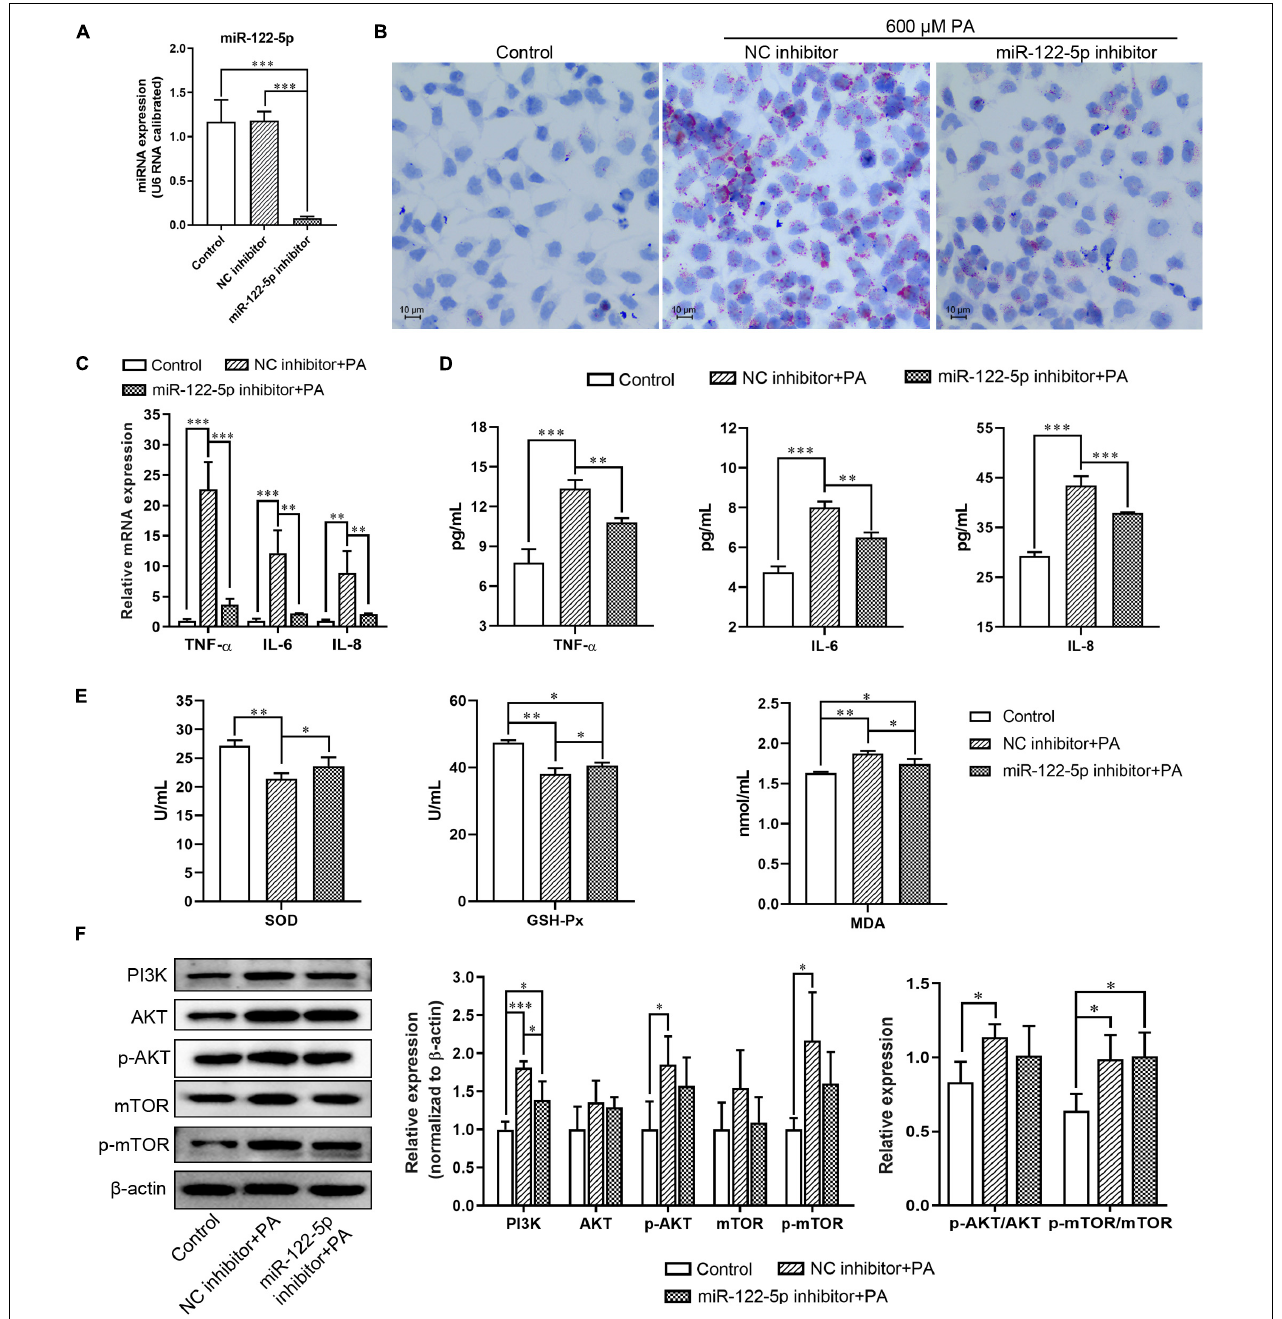
FIGURE 2 | MiR-122-5p inhibition attenuates PA-induced inflammatory and oxidative stress response in L02 cells. (A) L02 cells were transfected with lentivirus encoding miR-122-5p antisense (miR-122-5p inhibitor) or control sense [negative control (NC) inhibitor] for 48 h, and reverse transcription and quantitative PCR (RT-qPCR) analyzed the expression level of miR-122-5p. (B) Representative Oil Red O staining. (C) RT-qPCR analyzed the expression of tumor necrosis factor alpha (TNF- α ), interleukin (IL)-6, and IL-8. (D) ELISA analyzed the level of TNF- α , IL-6, and IL-8 in culture supernatants. (E) The activity of SOD and GSH-Px, and the content of MDA. (F) Western blot analysis of PI3K, AKT, p-AKT, mTOR, and p-mTOR expression. Error bars indicate SD. * P < 0.05, ** P < 0.01, *** P <